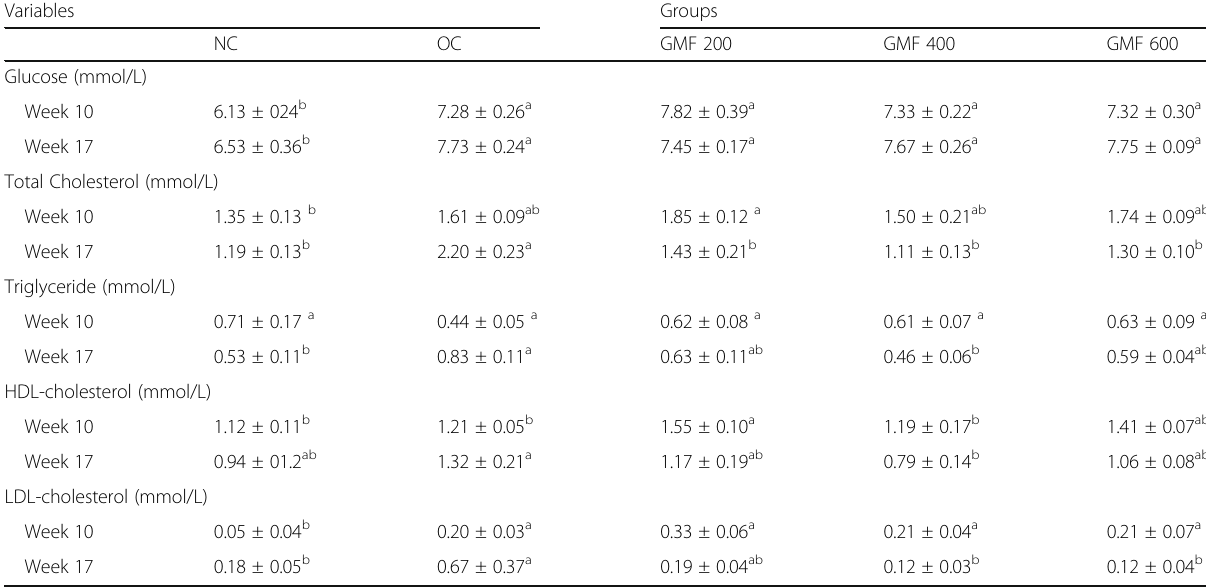
Table 2 The effect of GMF supplementation on plasma glucose and lipid profile Variables Groups